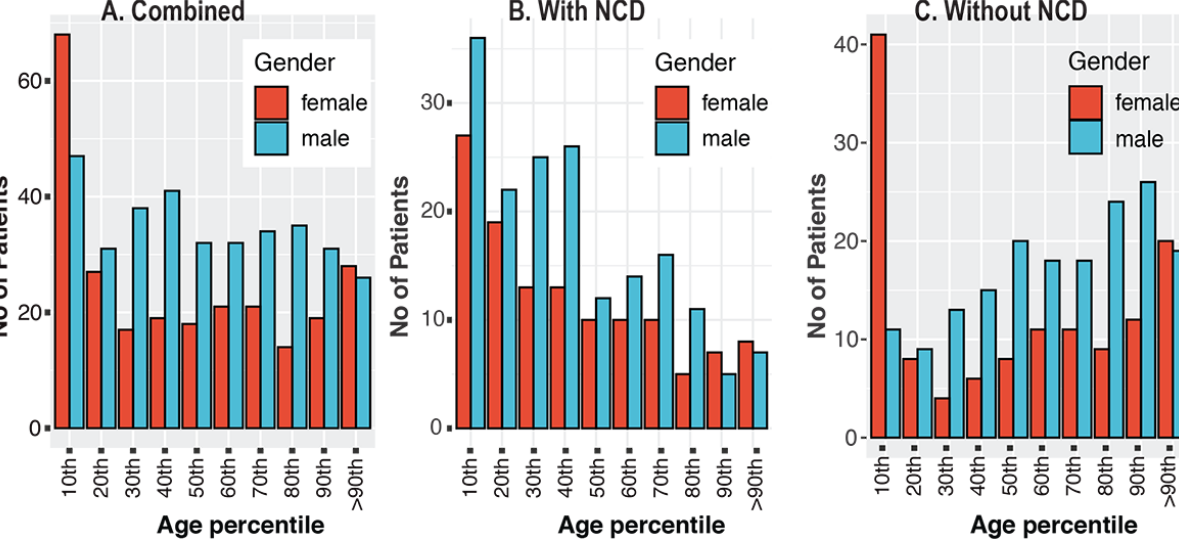
Figure 2. Age percentiles of patients with COVID-19 for (A) both patient groups, (B) patients with NCDs, and (C) patients without NCDs. NCD: noncommunicable